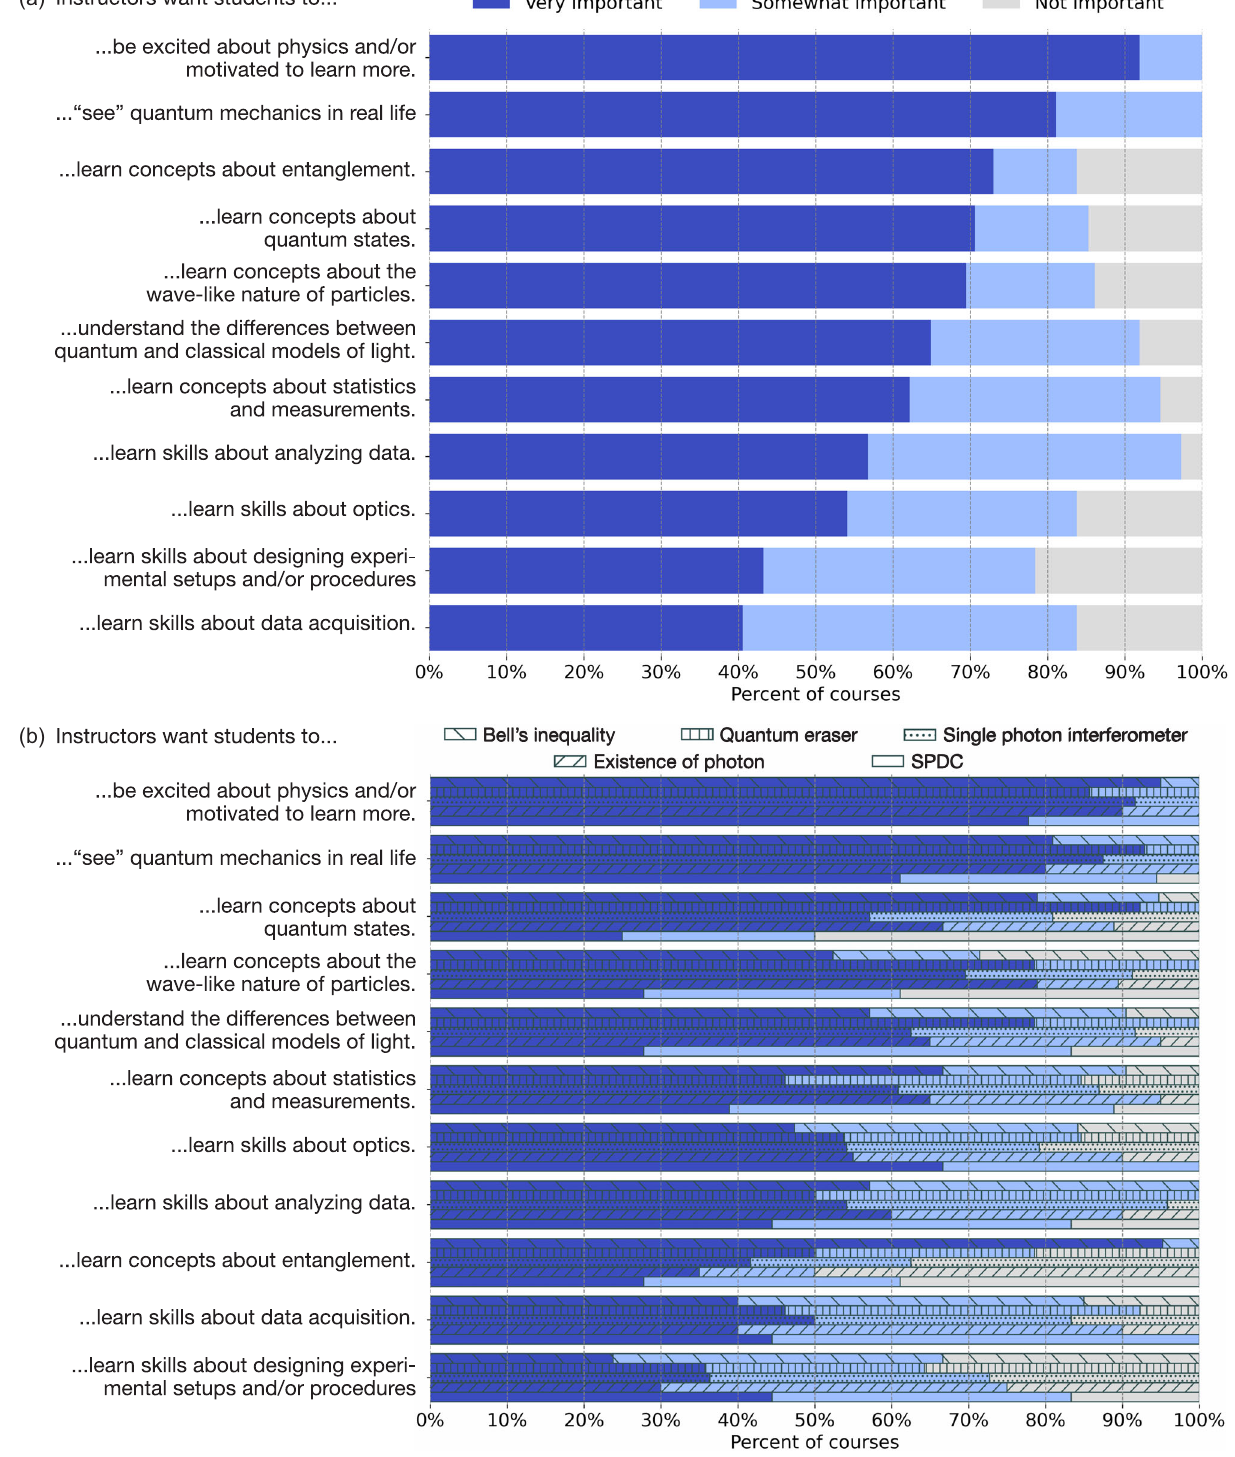
FIG. 4. (a) Percent of courses in which the instructor marked very important (dark blue), somewhat important (light blue), and not important (gray) as the highest level of importance for the given goal over all experiments used in their course. Due to a few missing responses, the number of courses N ¼ 34 for the goal of learning concepts about quantum states, N ¼ 36 for the goal of learning concepts about the wavelike nature of particles, and N ¼ 37 for all other goals. (b) Percent of courses using each experiment in which the instructor ranked each goal as very important (dark blue), somewhat important (light blue), and not important (gray) for the five most common experiments (distinguished by hatching). The goals are sorted by the average percentage of very important rankings over the five